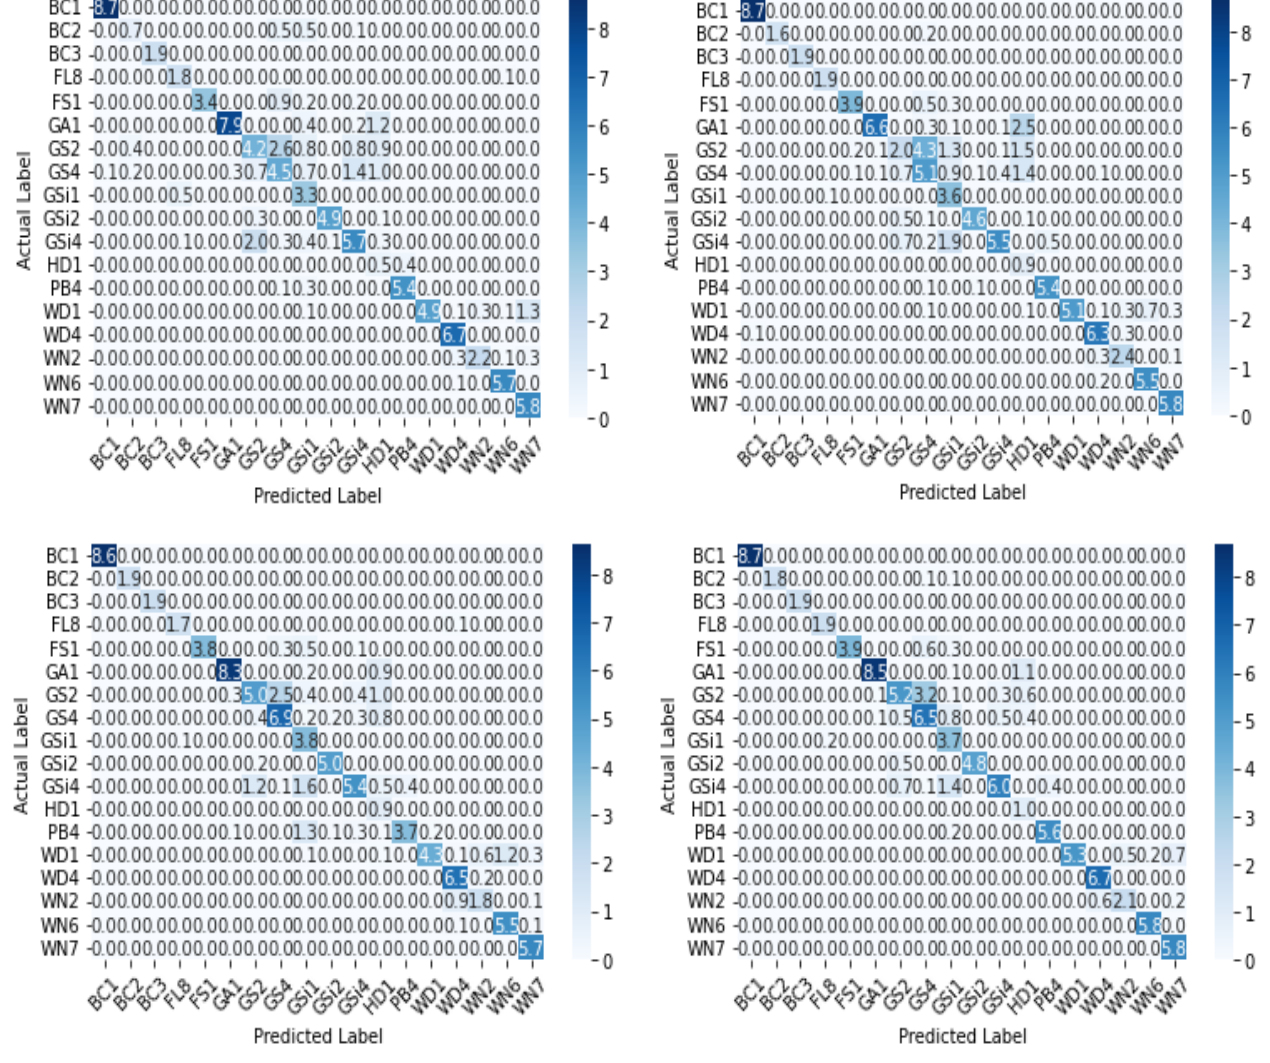
Figure 11. Confusion matrix (in %) of base-learners with VGG16, Resnet34, MobilenetV2, and Ensemble models, respectively. Table 4. Comparison of results achieved for various base-learners in combination with proposed classifiers. Best results achieved using the Stacked Ensemble model is indicated in bold.